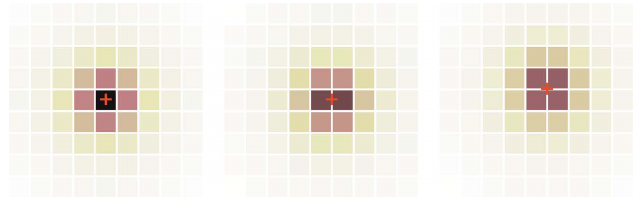
Figure 9 Three configurations of light sharing depending on the location of the X-ray interaction point with respect to the pixel matrix: center, edge or corner of a